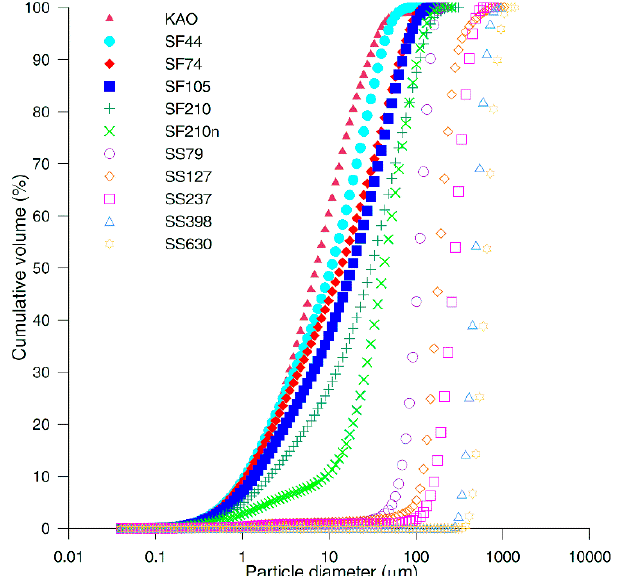
Figure 3. Cumulative particle diameter distributions of the flow-control granular materials (cakes) measured by the laser diffraction method: kaolinite (KAO), silica flour (SF), and silica sands (SS). The values of the median particle diameter obtained for each granular material are: KAO = 7.07 μ m, SF44 = 10.47 μ m, SF74 = 13.53 μ m, SF105 = 18.17 μ m, SF210 = 30.37 μ m, SF210n = 42.53 μ m, SS79 = 106.33 μ m, SS127 = 183.96 μ m, SS237 = 272.49 μ m, SS398 = 481.05 μ m, SS630 = 638.60 μ m.